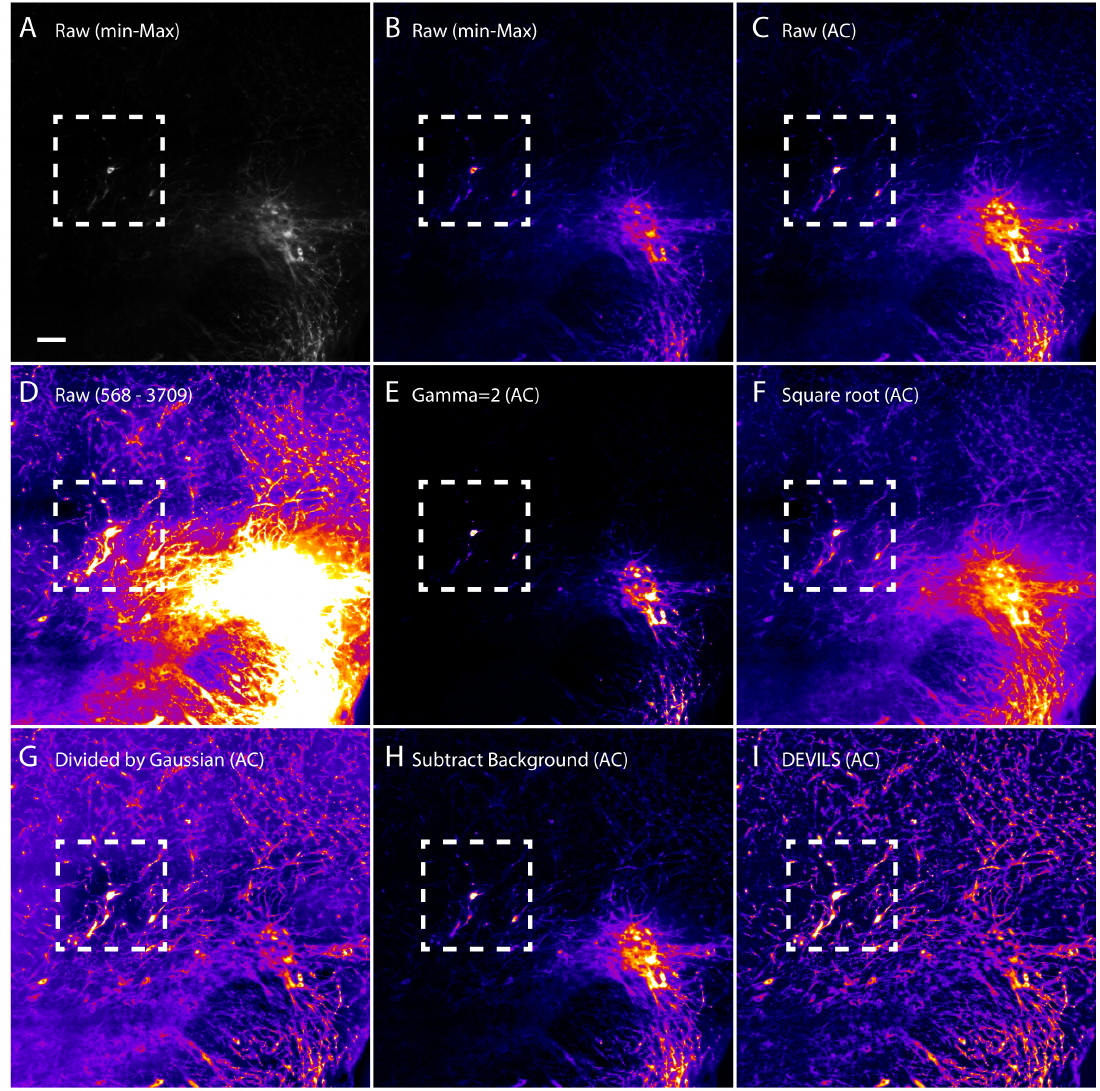
Figure 1. Comparison of different image display methods. An optical slice of a chemically cleared mouse midbrain was imaged with light-sheet fluorescence microscopy (LSFM) and different image processing operations are compared. Images are displayed using the Fire look-up table (LUT) except for A which is displayed in grey-scale. Apart from panels A , B and D , the auto contrast (AC) adjustment of Fiji was set to 0.35. ( A ) Unprocessed image displayed using a grey LUT with the minimum (min) and maximum (max) display settings set to the pixel histogram values (568 – 55656). Scale bar: 100 µm. ( B ) Unprocessed image displayed using the Fire LUT with the same display settings as in A . ( C ) Unprocessed image displayed using AC adjustment. ( D ) Unprocessed image displayed with min-max set to 568 – 3709 (3709 equals 1/15 th of the maximal intensity). ( E ) Original image displayed using Gamma adjustment (=2). ( F ) Original image after applying the Square Root operation. ( G ) Original image after a division by a spatially filtered version of the image (Gaussian blur, =50). ( H ) Original image after applying the ‘Subtract Background’ method from Fiji/ (radius = 25 px). ( I ) Original image after applying the DEVILS plugin with p =